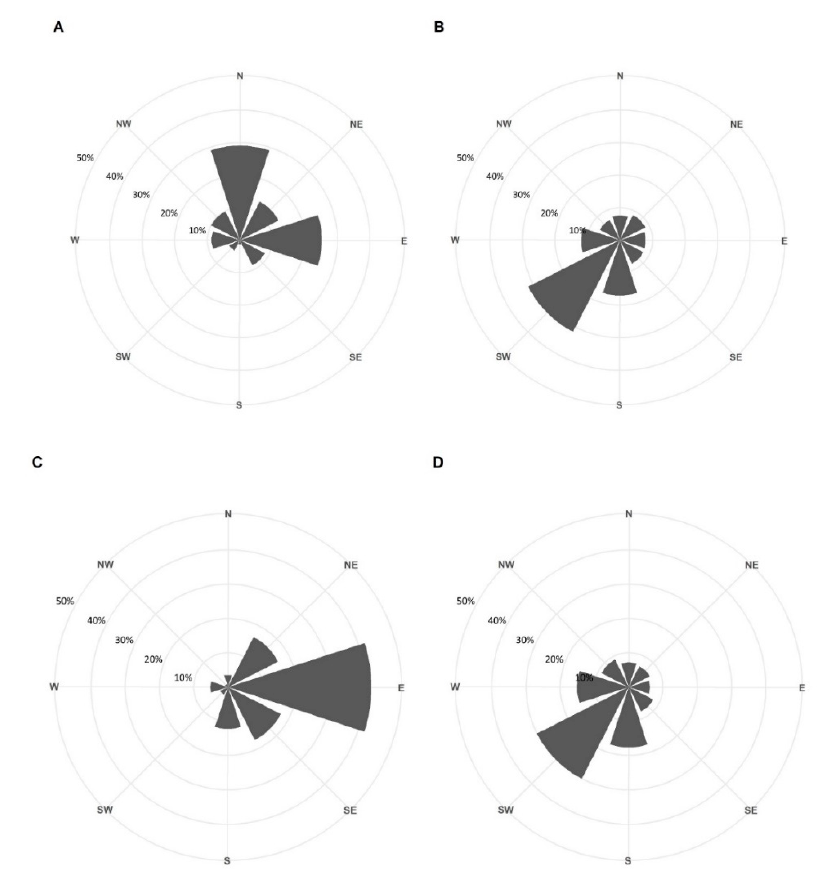
Table 3). During the 2017 and 2020 surveys, the wind was dominantly coming from the SW, both in the offshore and nearshore survey locations (Figure 4B,D).